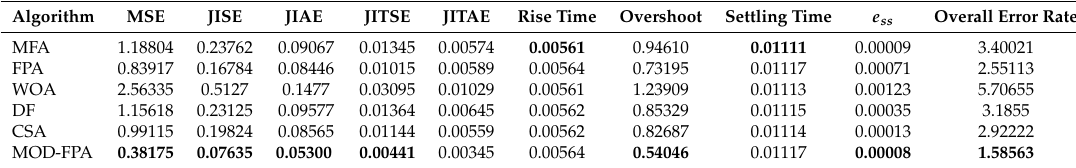
Figure 5. Simulation result for varying load and nominal parameters conditionn. Table 7. Performance analysis for speed tracking task with constant load and nominal parameters